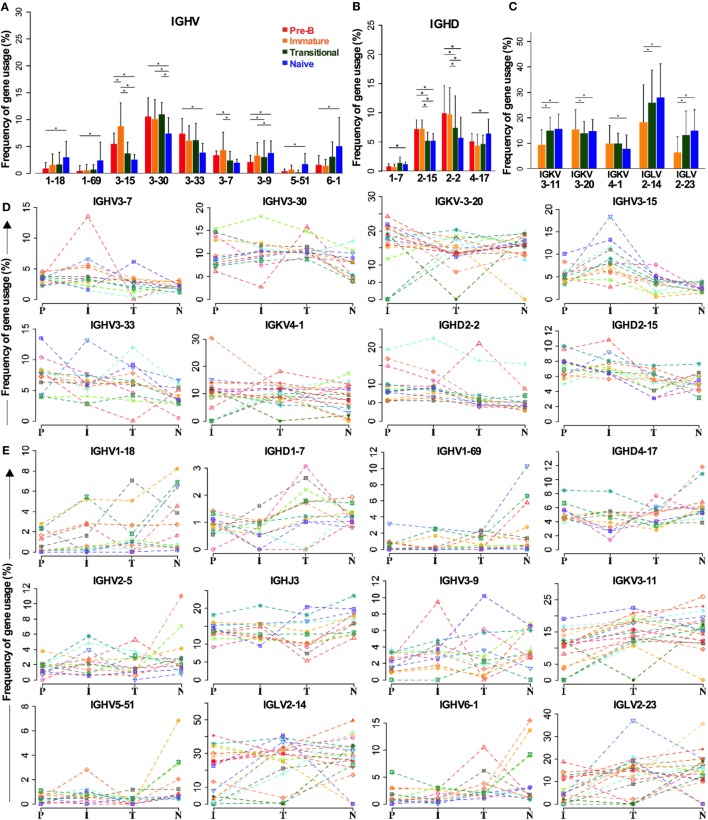
Individual genes can be favored or disfavored as B cells mature. (A–C) Frequency of IGHV (A) and IGHD (B) gene usage in heavy chain and IGKV and IGLV usage in light chains (C) of different cell types are compared (*p < 0.05 by two way ANOVA with multiple analysis correction. Error bars are SEM). (D,E) The frequency for each cell type in each individual donor is shown for genes that are decreased during selection (D) and those that are increased (E).